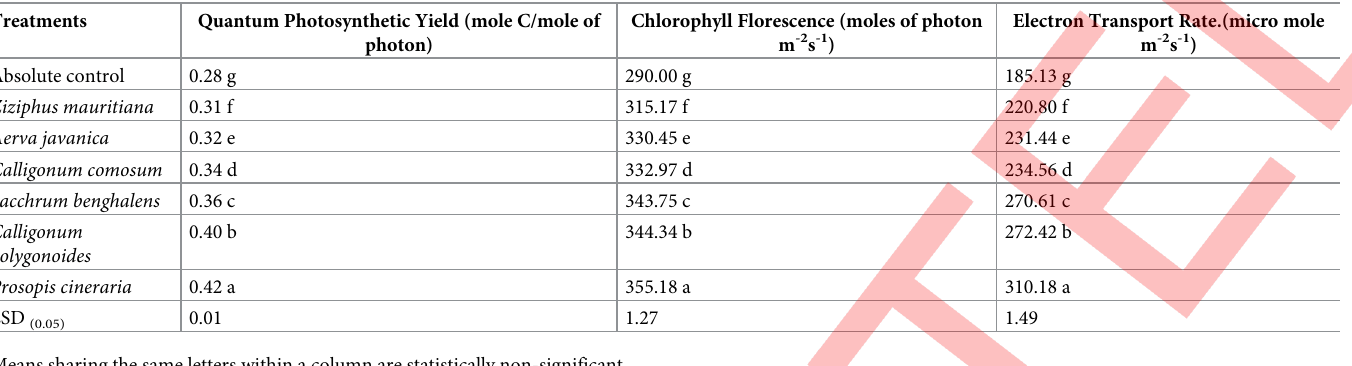
Table 6. The impact of different vermicompost treatments on quantum photosynthetic yield, chlorophyll florescence and electron transport rate. Treatments Quantum Photosynthetic Yield (mole C/mole of